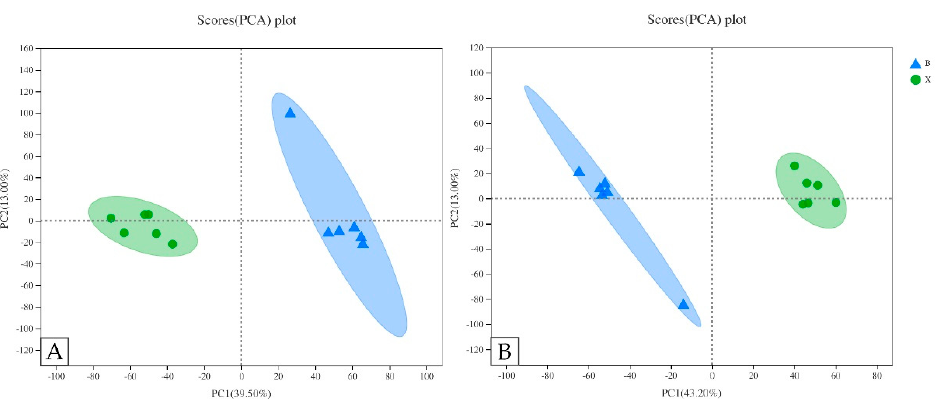
Figure 5. PCA score plots of different samples. ( A ) PCA score plots of two groups in cationic mode (positive ion). ( B ) PCA score plots of two groups in anionic mode (negative ion). The confidence ellipse indicates that the “true” samples of this group are distributed within this region at 95% confidence level; beyond this region, the samples are considered as possible outliers.